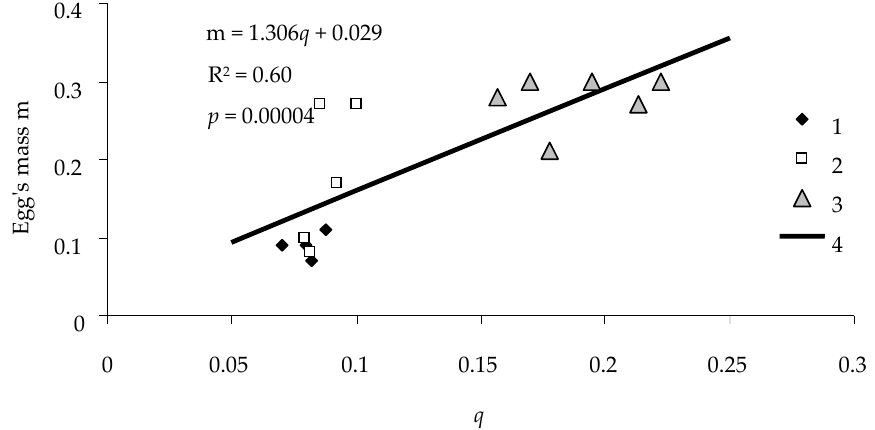
Figure 8. The relationship between caterpillar feeding efficiency q and caterpillar fecundity F (weight of laid eggs) for insects reared on all types of feed. Host plant species: (1) pine; (2) larch; (3) birch; (4) regression line for caterpillars feeding on all the host species.